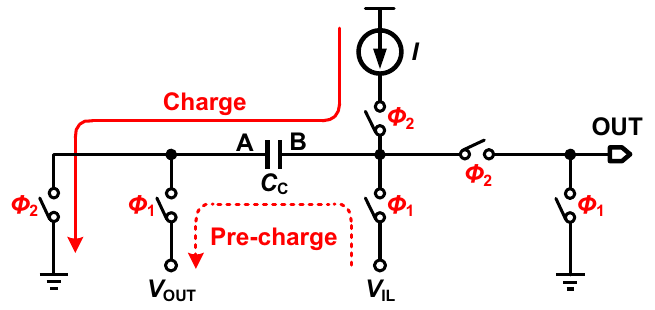
Figure 5. The circuit scheme of the voltage